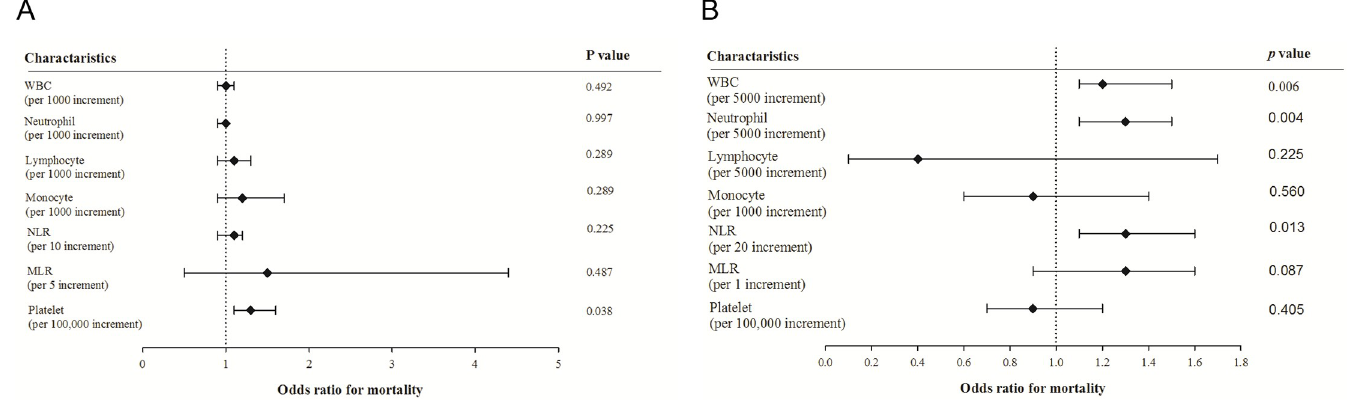
Fig 3. The association between immune cell profiles and mortality in patients hospitalized with pneumonia. A. The odds ratios for mortality in patients with eGFR � 55 mL/min/1.73 m 2 . B. The odds ratios for mortality in patients with eGFR < 55 mL/min/1.73 m 2 . WBC, white blood cell; NLR, neutrophil-to-lymphocyte ratio; MLR, monocyte-to-lymphocyte